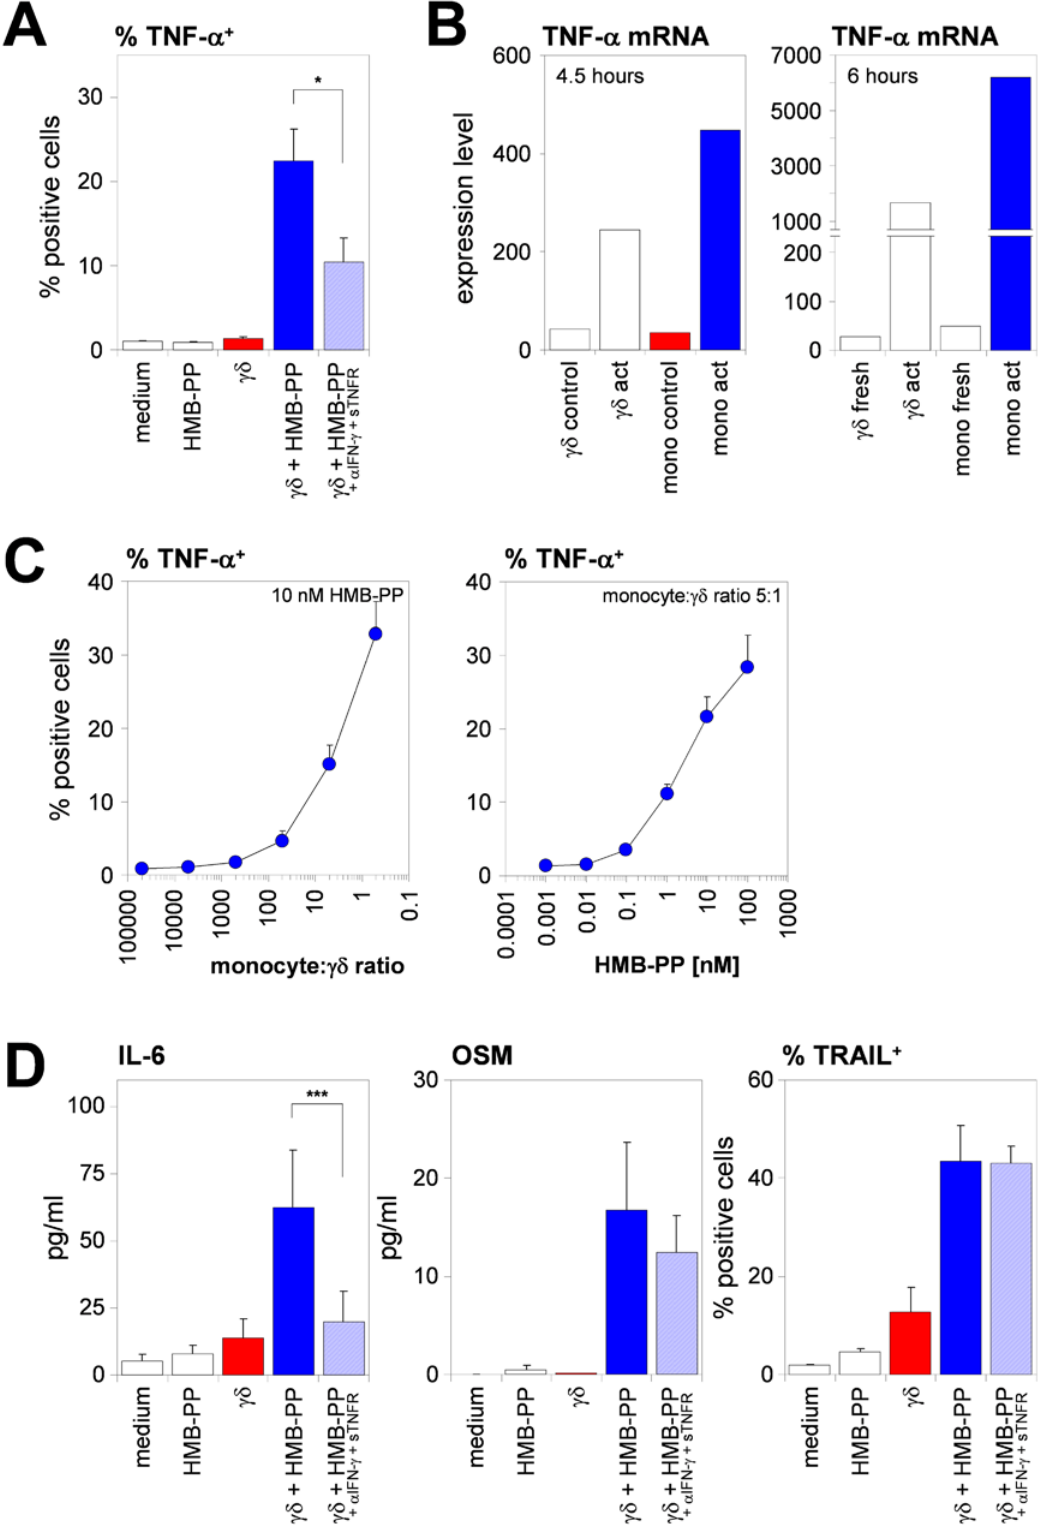
Figure 5. V c 9/V d 2 T cell-activated monocytes produce inflammatory mediators. ( A ) Mean percentages 6 SEM of TNF- a + monocytes after 18 hours of culture under the conditions indicated ( n =3–7). ( B ) Mean mRNA expression levels of TNF- a from duplicate measurements for activated monocytes and cd T cells sorted after 4.5–6 hours from co-cultures in the presence of HMB-PP, compared with control cells sorted from co-cultures in the absence of HMB-PP (left), or with freshly isolated, resting monocytes and cd T cells (right). ( C ) Mean percentages 6 SD of TNF- a + monocytes co- cultured with cd T cells at various ratios in the presence of 10 nM HMB-PP (left), or with cd T cells at a ratio of 5:1 in the presence of different concentrations of HMB-PP (right), as analyzed after 18 hours in triplicate cultures. ( D ) Mean protein levels (pg/ml) 6 SEM of secreted IL-6 and OSM, and mean percentages 6 SEM of TRAIL + monocytes after 18 hours of culture under the conditions indicated ( n =3–7).